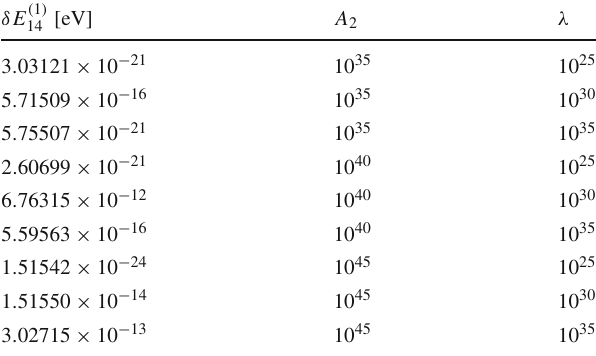
Table 3 δ E ( 1 ) for 1 mirror, viz. Eq. (87), for the value ρ = 2 . 51 g/cm 41